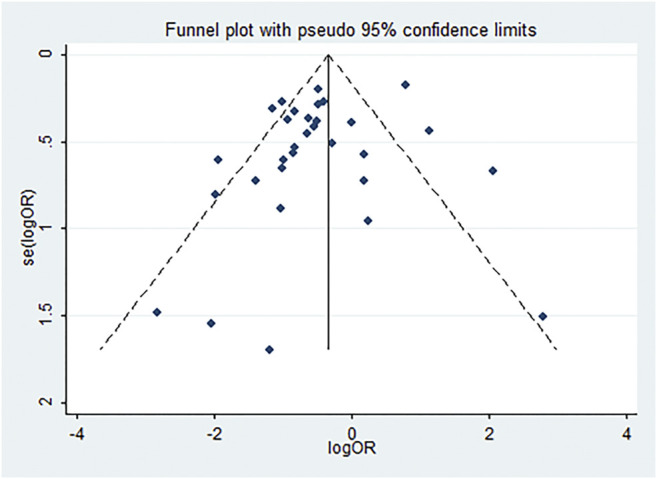
Funnel plot analysis of publication bias. Publication bias of the 31 studies. Dots symbolizing studies mostly clustered in the middle and at the top of the funnel plot; both sides are nearly symmetrical, and only eight articles are outside the funnel plot.